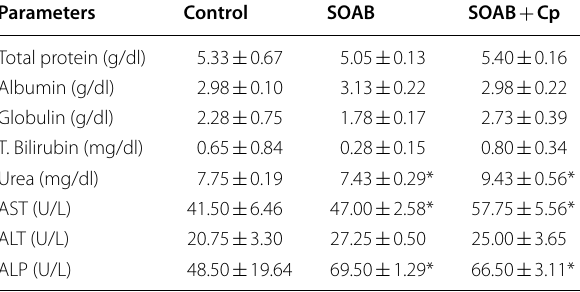
Data are the mean of three replicates (n *Shows significant difference at p < 0.05 for each experimental groups compared to the control group